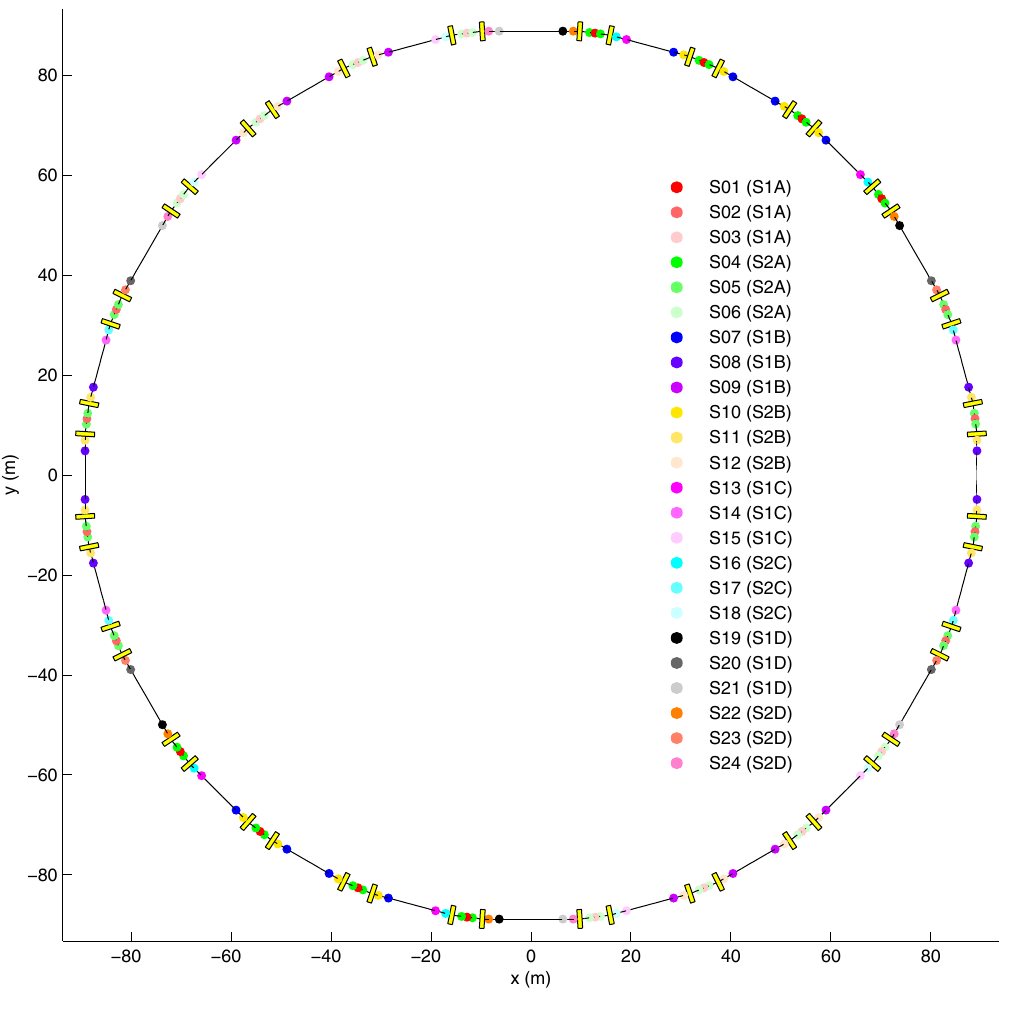
FIG. 7. Sextupole families for Diamond including the additional families introduced to generate “ smart sextupole knobs ” according to the on-line SRM technique. The old family split is indicated in the